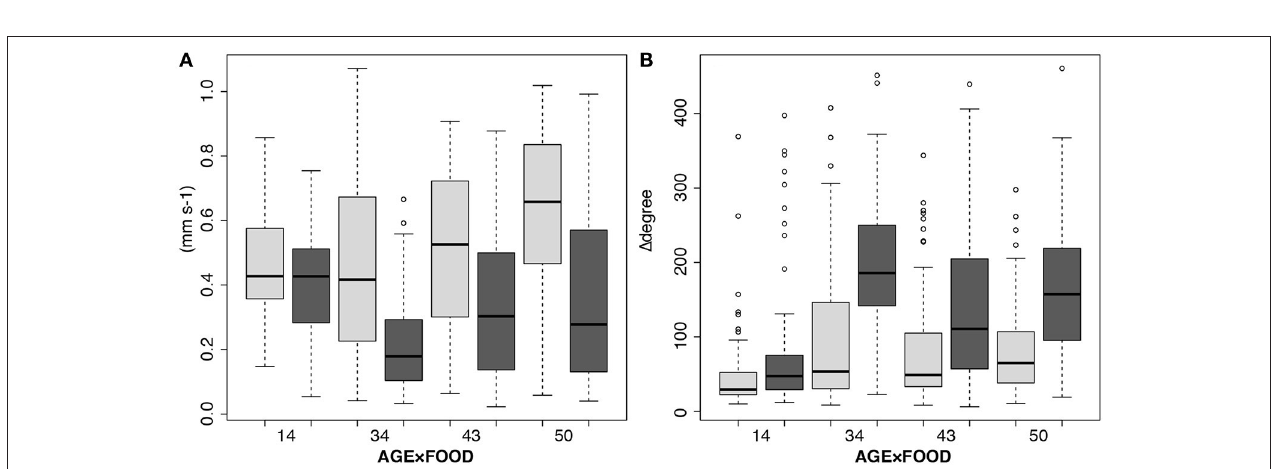
FIGURE 3 | Boxplots of the response to different types of food in 14-days-old planulae. (A) Swimming velocity (mm s − 1 ), and (B) Swimming behavior (sums of change of angles). NO, no food; COP, copepod homogenate; MA, microalgae; FB, fish blood; SD, dissolved amino acids and trace elements.